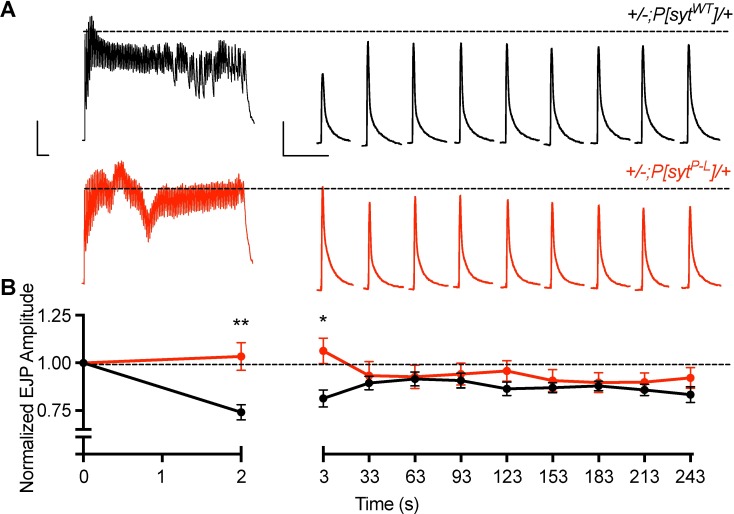
The sytP-L mutation does not result in synaptic depression during and shortly after a high frequency 50 Hz stimulation, but this relative increase in release is short-lived.(A) Representative traces for control and P[sytP-L] heterozygotes showing the initial 2 second 50 Hz train, followed by each post-train pulse at 1 second, then every 30 seconds thereafter for 4 minutes. Dotted line represents the amplitude of the initial response. Scale bar represents 10 mV, 0.1 s. (B) Average EJP amplitude during and after 50 Hz stimulation in control (n = 18) and P[sytP-L] heterozygotes (n = 24). Responses were normalized to the amplitude of the initial response. Unlike controls, P[sytP-L] heterozygotes do not exhibit synaptic depression at the end of the stimulus train (p << 0.0001) and 1 second after cessation of the train (p = 0.0012). Error bars depict SEM.